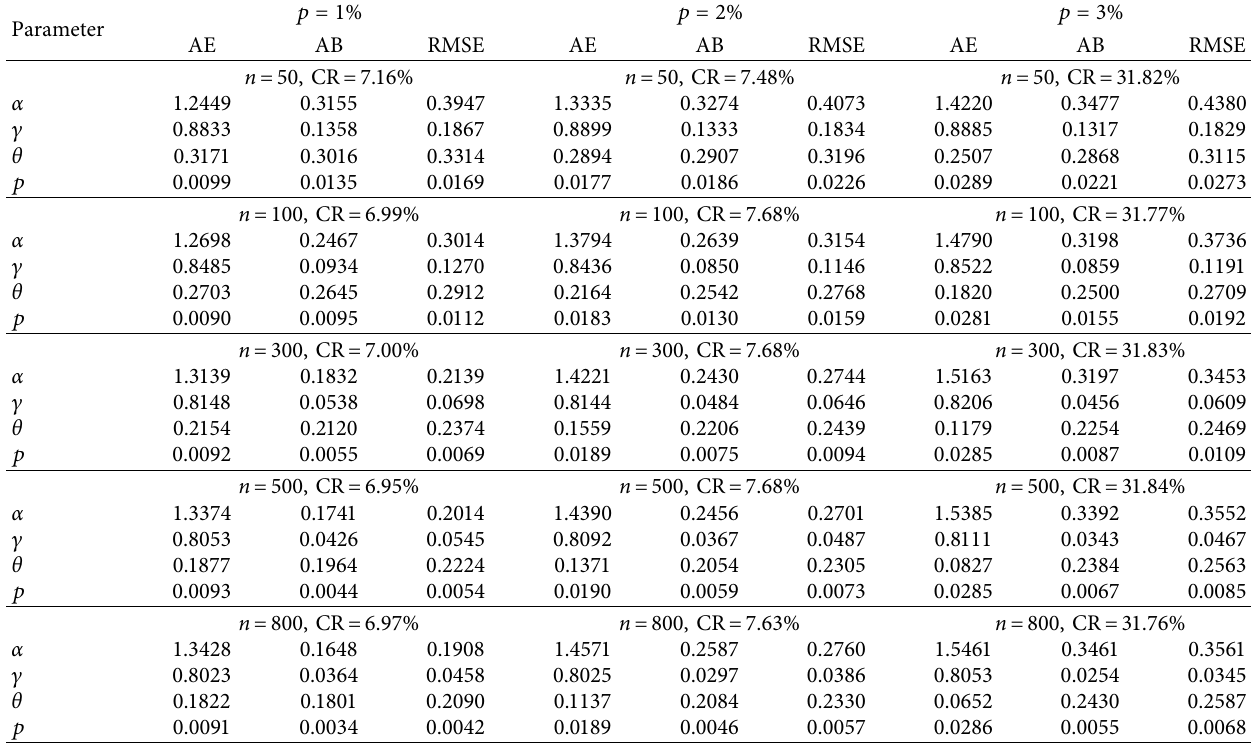
Table 1: Simulation results of SWGI distribution for parameter values ( α , c , θ ) � ( 1 . 2 , 0 . 8 , 0 . 3 ) .